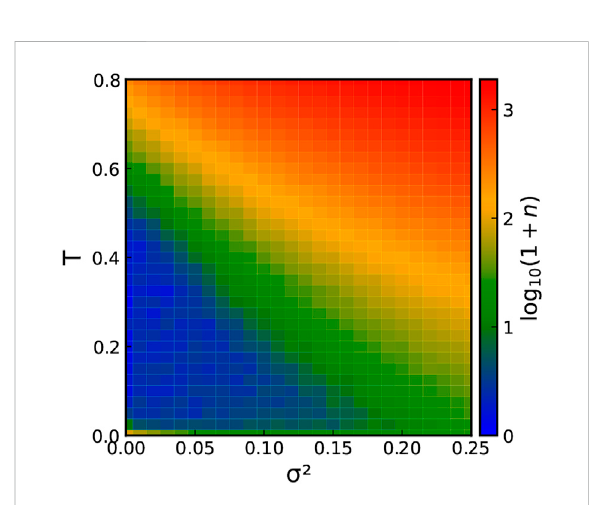
FIGURE 5 Color map of the number of the number of defects n (in log- scale, log 10 (1 + n )) over the parameter space σ 2 − T in the steady state. In the blue region defects are scarce in the system, while in the red one the system is populated by lots of defects (the number growing exponentially fast as one leaves the blue